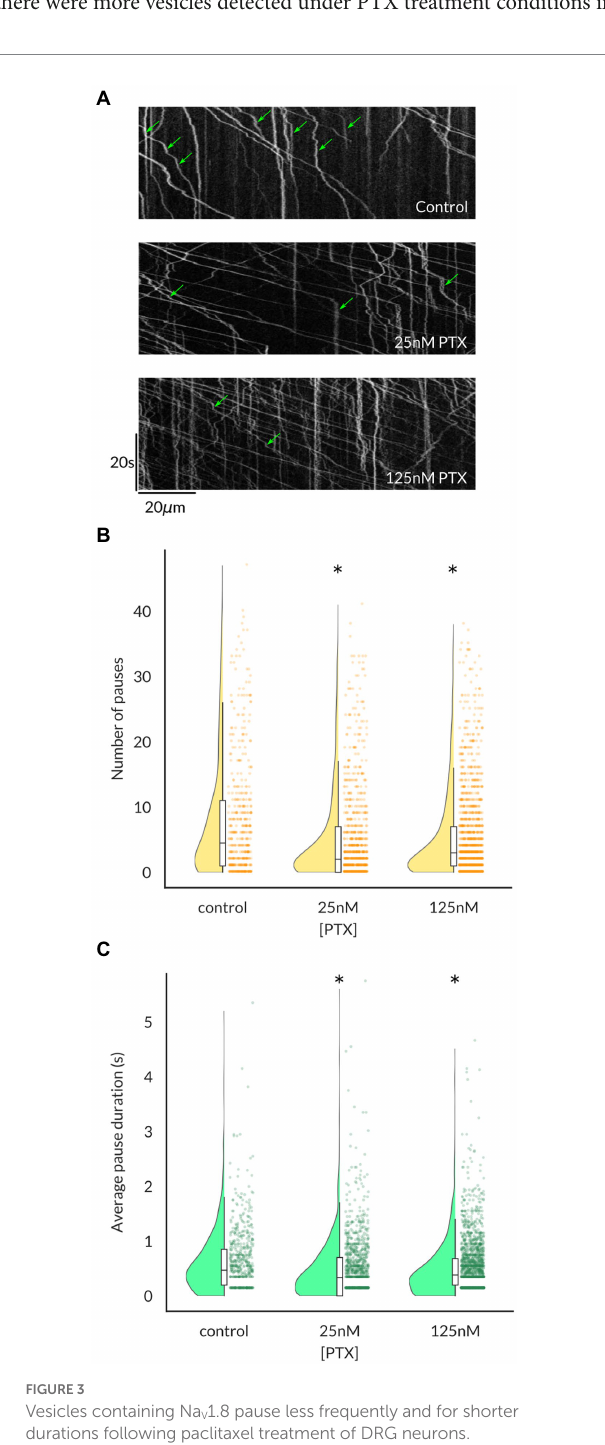
FIGURE 4 Paclitaxel enhances flux of vesicles containing Na V 1.8. The vesicular flux, defined as the number of vesicles traversing half of the imaged axon per minute, was significantly increased by treatment with 125 nM PTX ( p = 0.025 by corrected Mann–Whitney U test). At least 3 independent cultures were analyzed per condition; each point indicates an individual